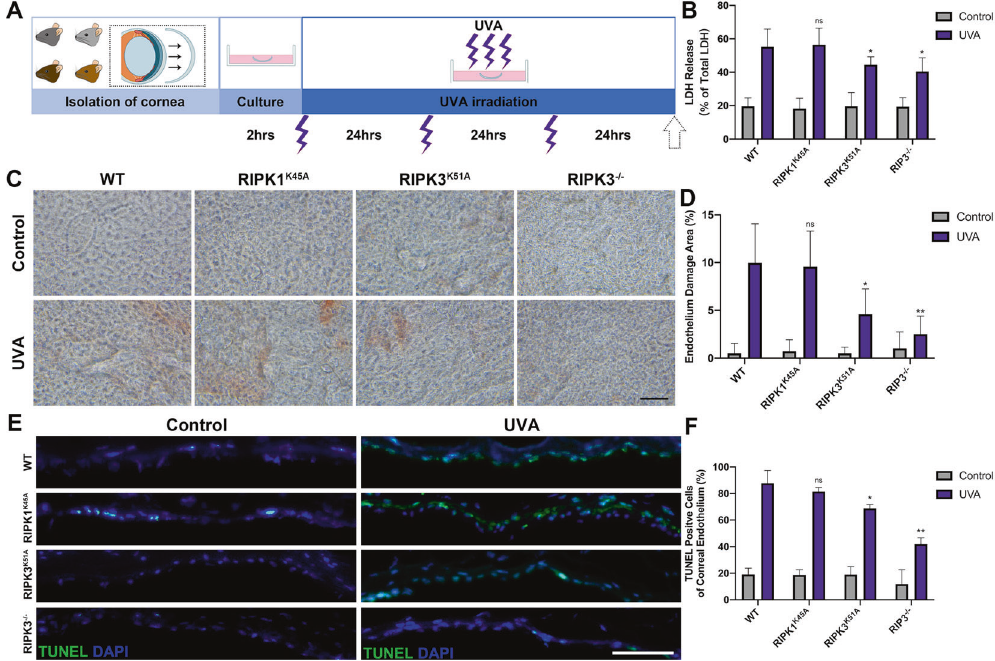
Fig. 5 The inhibition of RIPK3 protein expression attenuates cell death after UVA irradiation in transgenic mice CE. A Flow chart of Wild- type, RIPK1 K45A , RIPK3 K51A , RIPK3 − / − cornea culture ex vivo and UVA irradiation model. B LDH release assays of transgenic mice CE after UVA irradiation ( n = 6 per group). C Alizarin red S staining in transgenic mice CE with control and UVA irradiation (Scale Bar: 20 μ m). D Endothelium damage area (%) was analyzed by measuring the Alizarin red S-positive area ( n = 5 per group). E Representative immuno fl uorescence images of TUNEL (Green) and DAPI (Blue) in transgenic mice CE (Scale Bar: 10 μ m). F TUNEL-positive cells (%) were quanti fi ed and compared among transgenic mice ( n = 3 per group). Statistical signi fi cance was analyzed with the unpaired Student ’ s t -test. ** P < 0.01 , *** P < 0.001 , **** P < 0.0001 . All values are expressed as mean ±